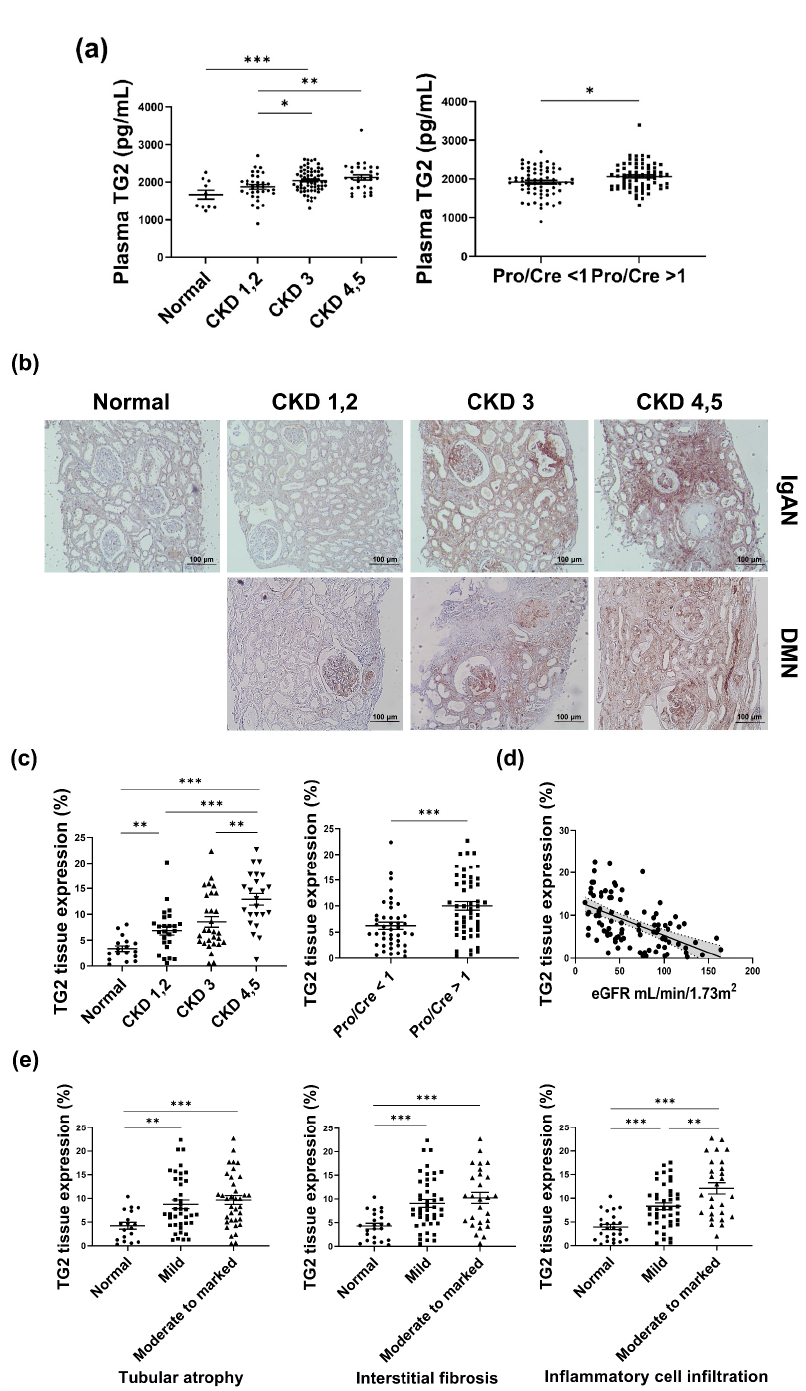
Figure 2. TG2 levels were increased with deterioration of kidney function and pathological aggravation in patient samples. ( a ) The concentration of TG2 was evaluated in the plasma of CKD patients. ( b ) Representative images of immunohistochemical staining for TG2. ( c ) Differences in the tissue expression level of TG2 according to kidney function markers, including CKD stage and urine protein/creatinine ratio. ( d ) Association between TG2 expression and eGFR. ( e ) Differences in TG2 expression levels according to tubular pathology (* p < 0.05, ** p < 0.01, *** p <